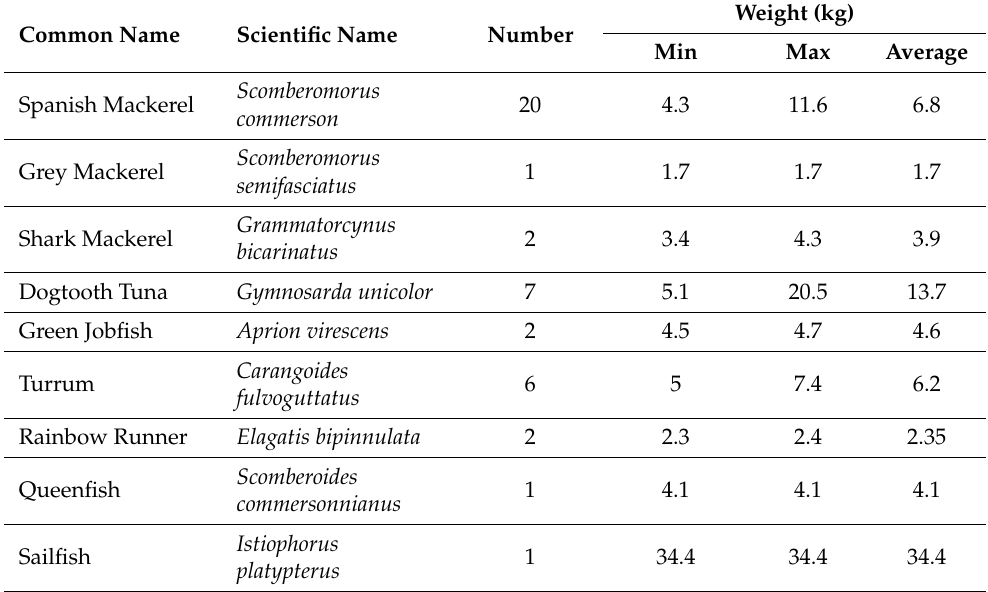
Queensland Bluewater International (NQBI) in